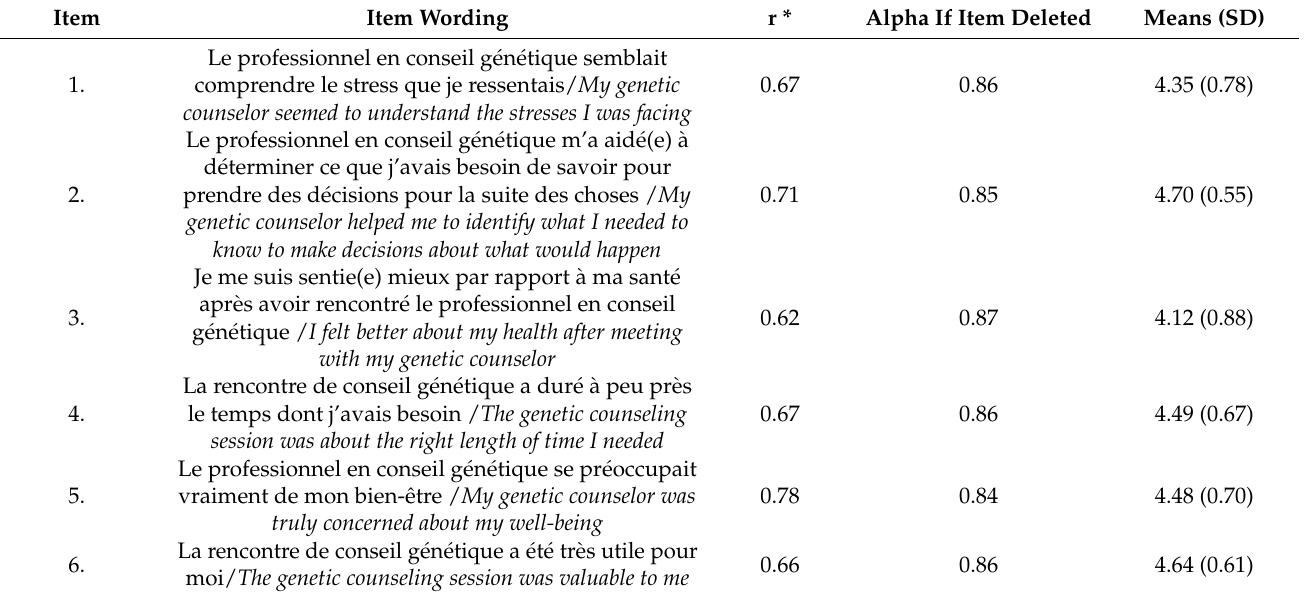
Table 2. Reliability analysis and descriptive